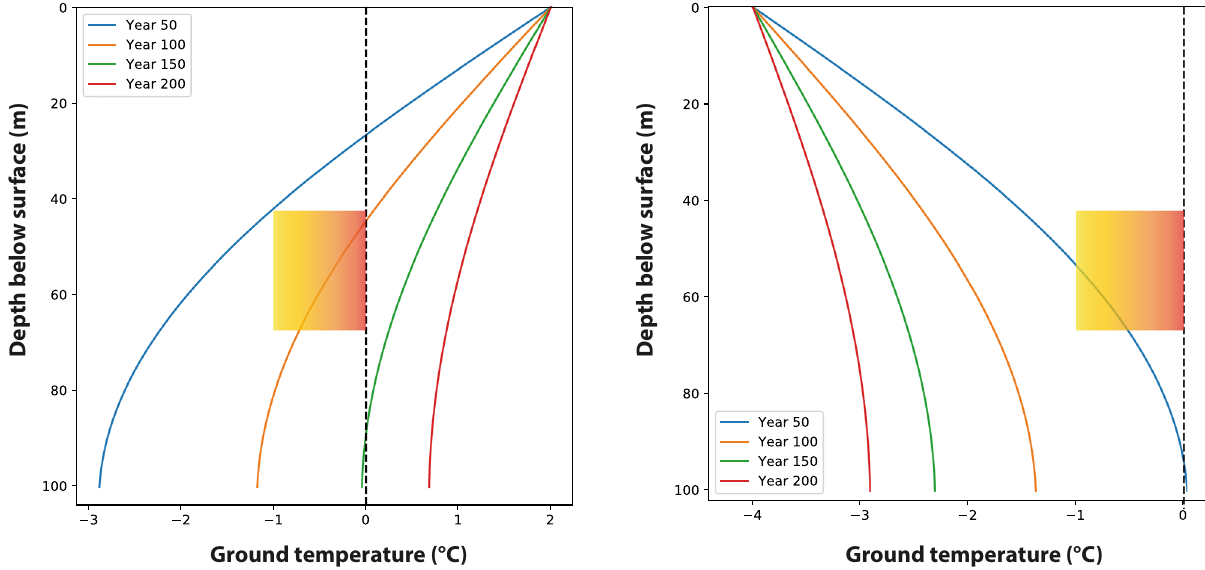
Fig. 3 Scenario 2 simulating the degradation of permafrost during the transient warming associated with a 200 yr-long interstadial (left) and the thermal regime of the subsurface following the end of this warming (right). The mean annual air temperature at the ground surface is increased from − 4 °C to 2 °C (left) and then reversed after 200 yr (right). The curves depict the mean annual temperature. The rectangles with the orange shading mark the − 1 to 0 °C window of the possible formation of cryogenic cave carbonates for the depth range of the Obir